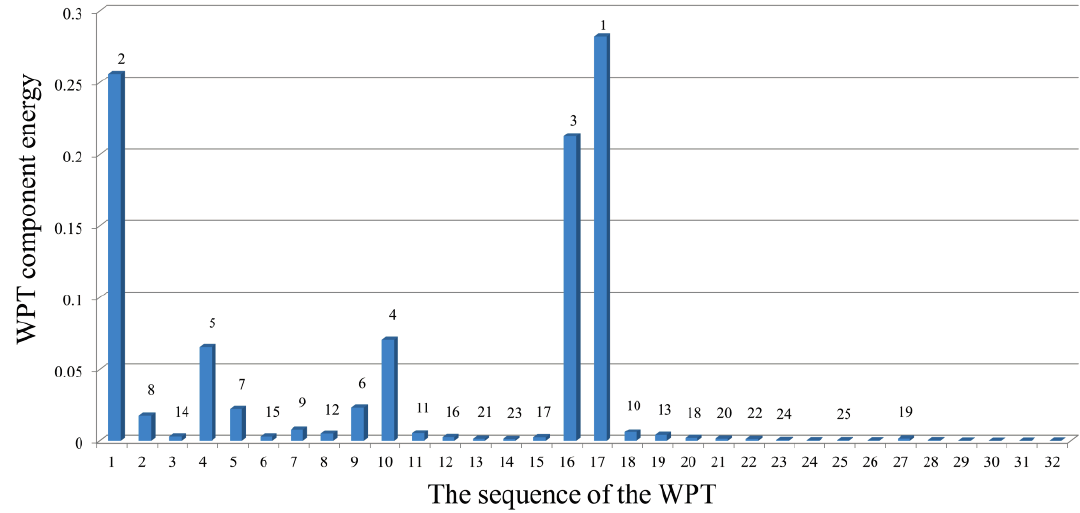
Figure 16. Relative energy distribution over the wavelet packet components at level